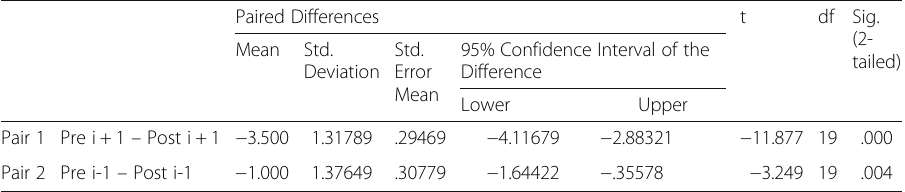
Table 5 Paired Samples Test (Pre and Post-tests of Both Group)